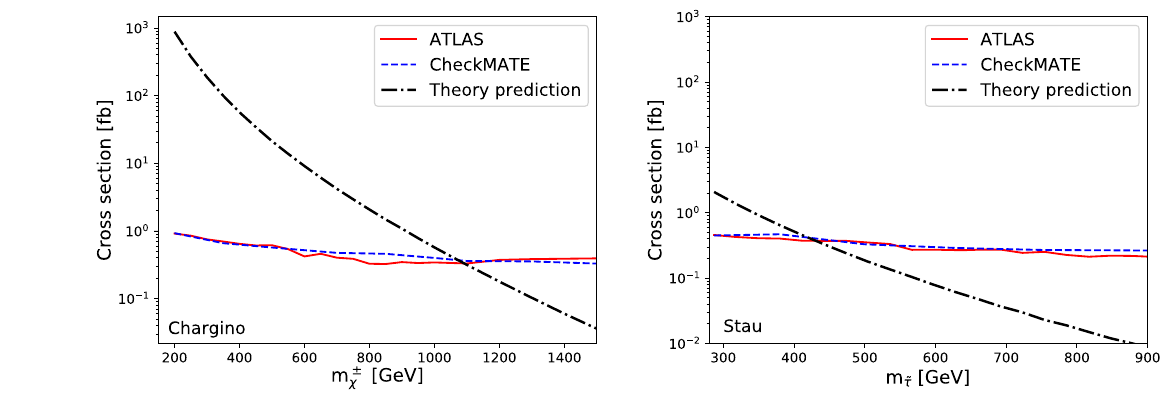
a solid red line while CheckMATE predictions are in form of a dashed blue line. The theory prediction is displayed as a dot-dashed black line